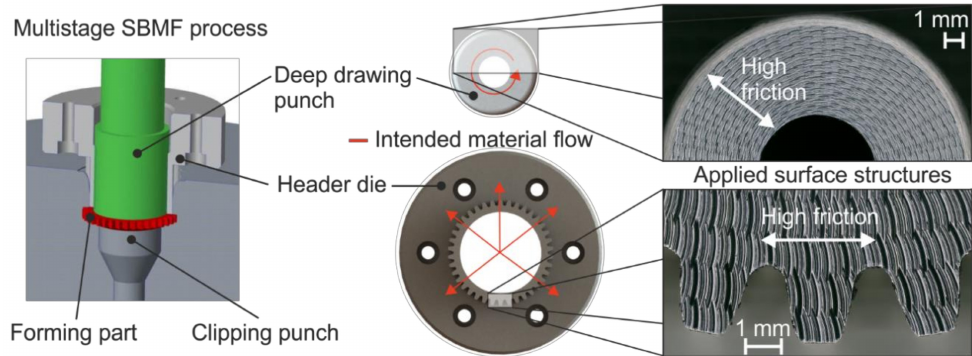
Figure 3. Multistage SBMF process ( left ) and modified functional surface HF 1 on deep drawing punch ( top right ) and header die ( bottom right